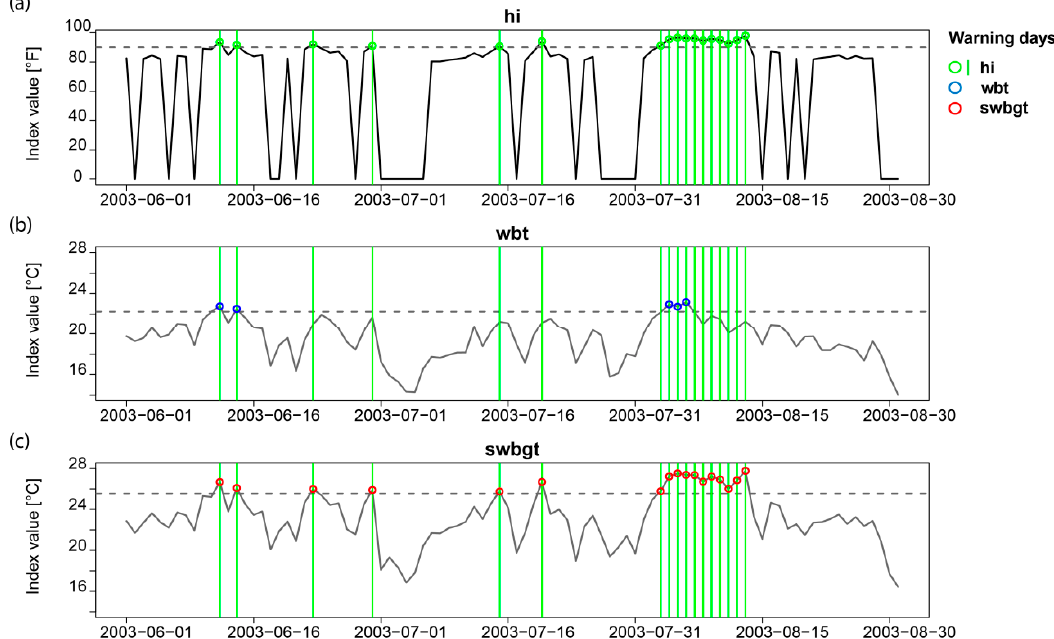
Figure 9. The daily evolution of hi ( a ), wbt ( b ) and swbgt ( c ) in Basel in summer 2003 and the respective warnings days: Green vertical lines ( a – c ) and green dots ( a ) show the official warning days based on hi , blue dots indicate warning days based on wbt ( b ) and red dots show warning days based on swbgt ( c ). Dashed horizontal lines mark the site-specific thresholds of each index.